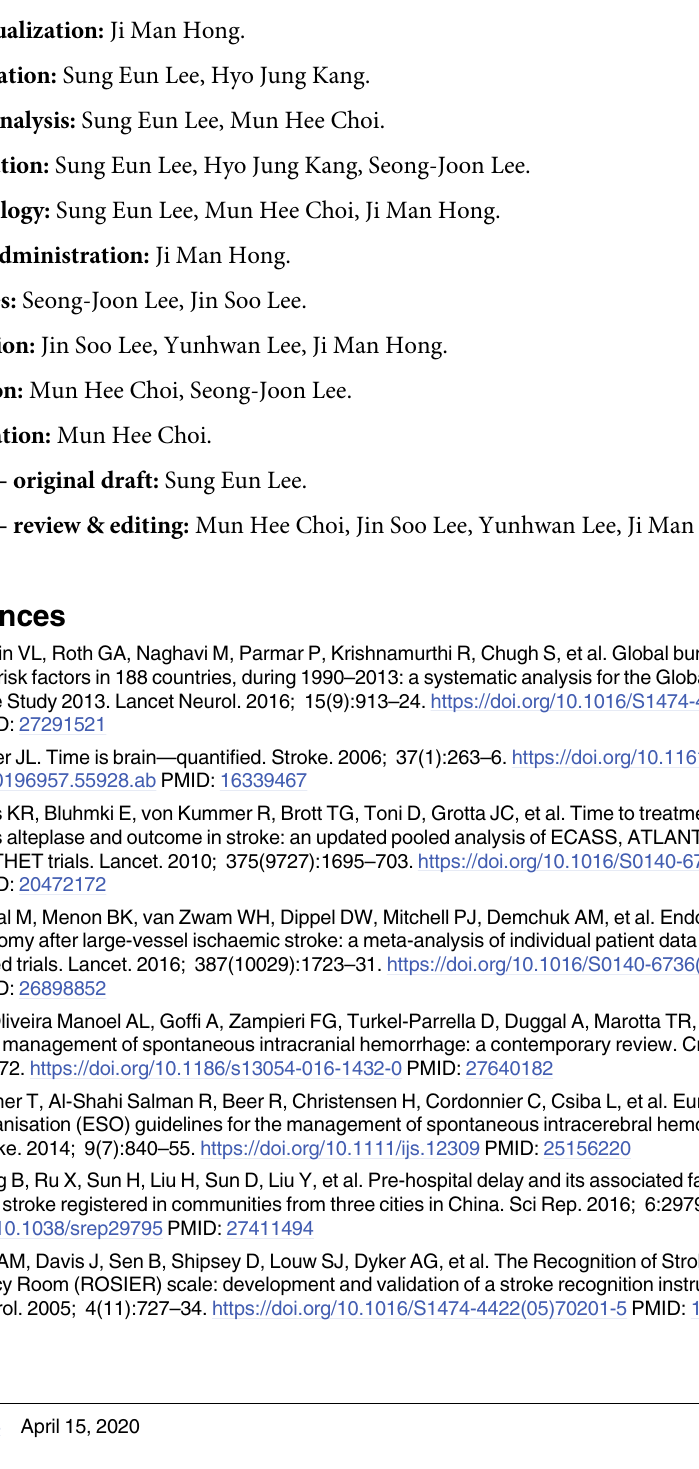
S2 Fig. Flow diagram of 1,621 suspicious stroke patients. (PDF) S3 Fig. Receiver-Operating Characteristic (ROC) curve and corresponding area under the curve (AUC) statistics of the CIVIL scoring system.